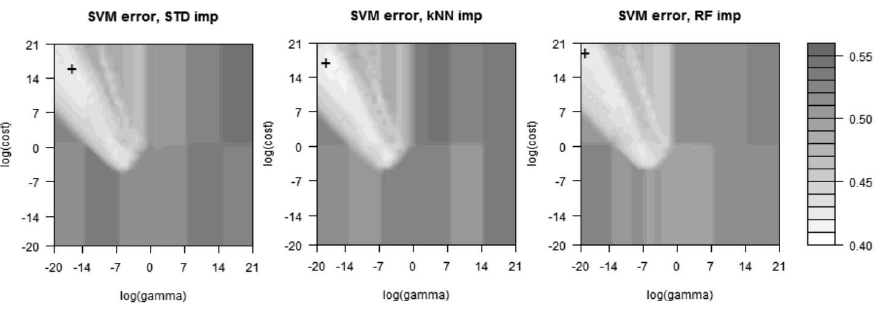
Figure 4. Results for SVM classifier – first parameter set